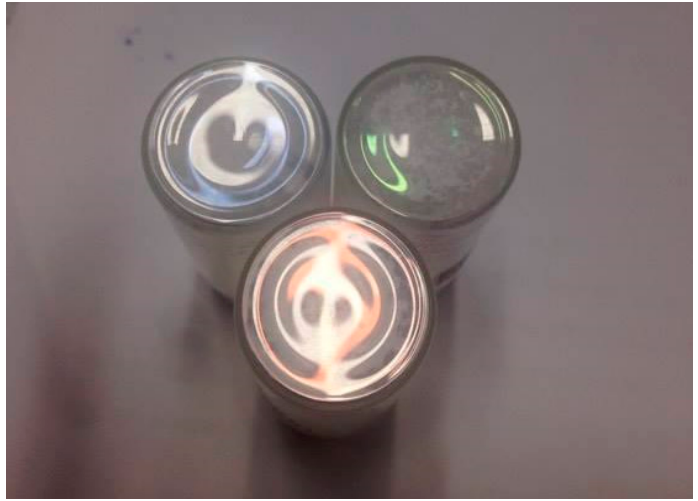
Figure 1. Silica-based photonic glass with various colors.